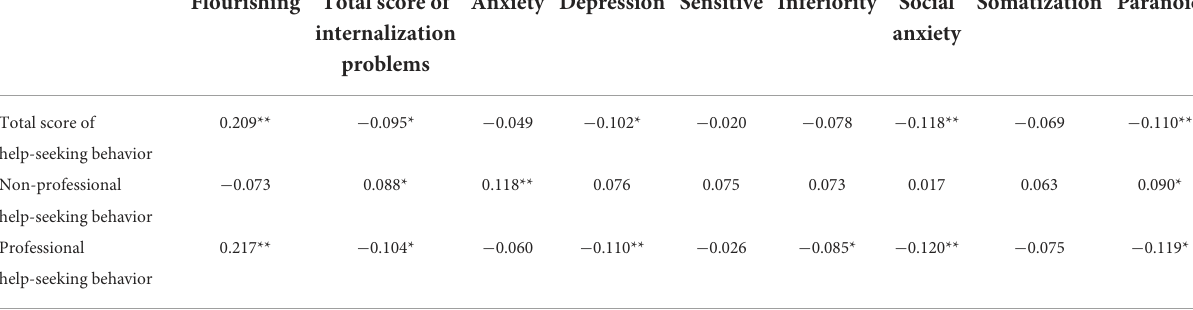
TABLE 9 Correlation between help-seeking behavior and mental health.